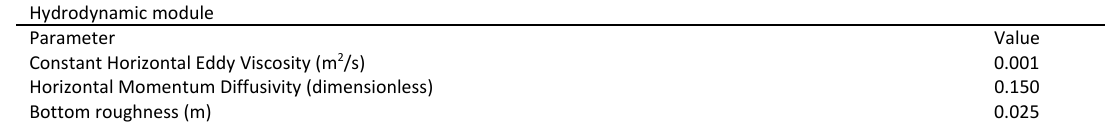
Table 4: Modified coefficients in the hydrodynamic component